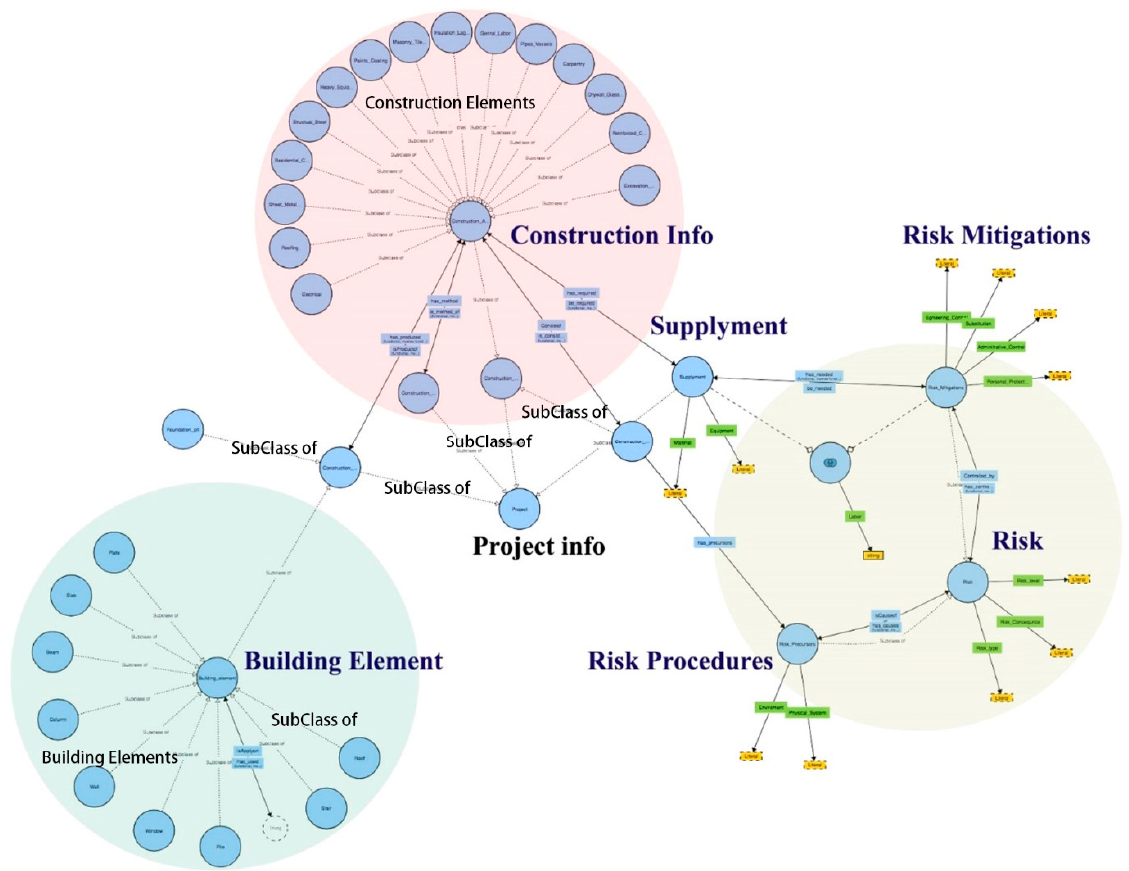
Figure 2. The overall class hierarchy of HSM-Onto.